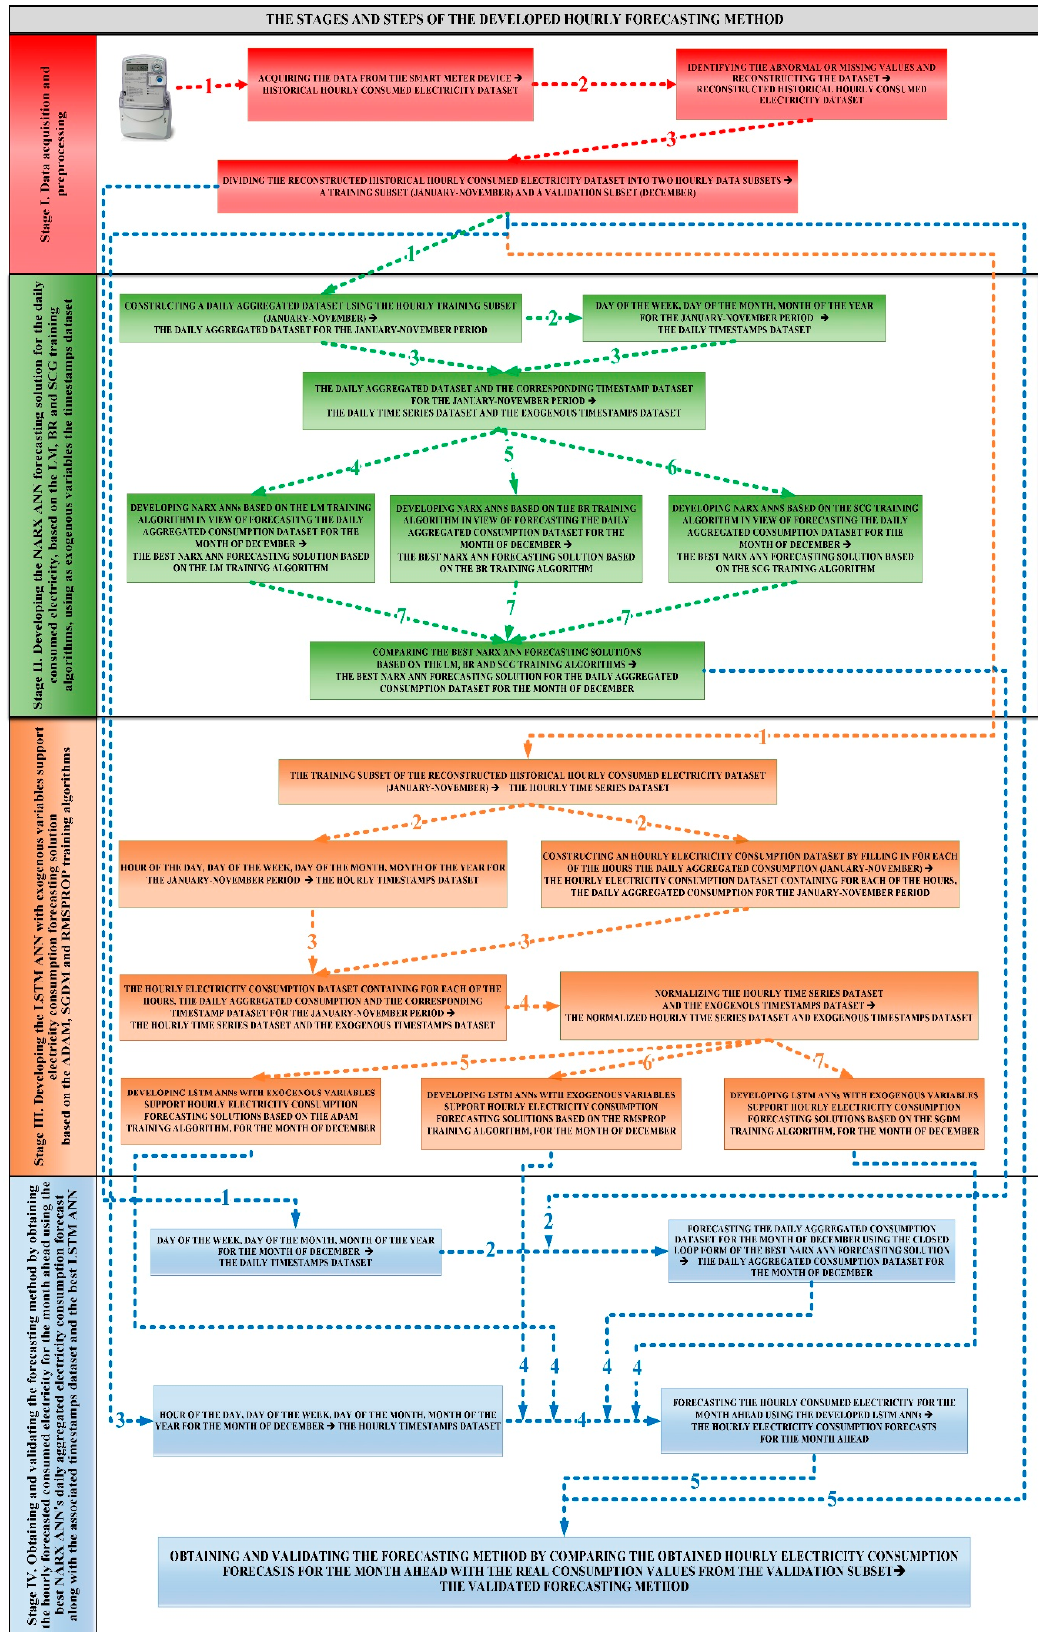
Figure 1. The flowchart of the developed forecasting method.